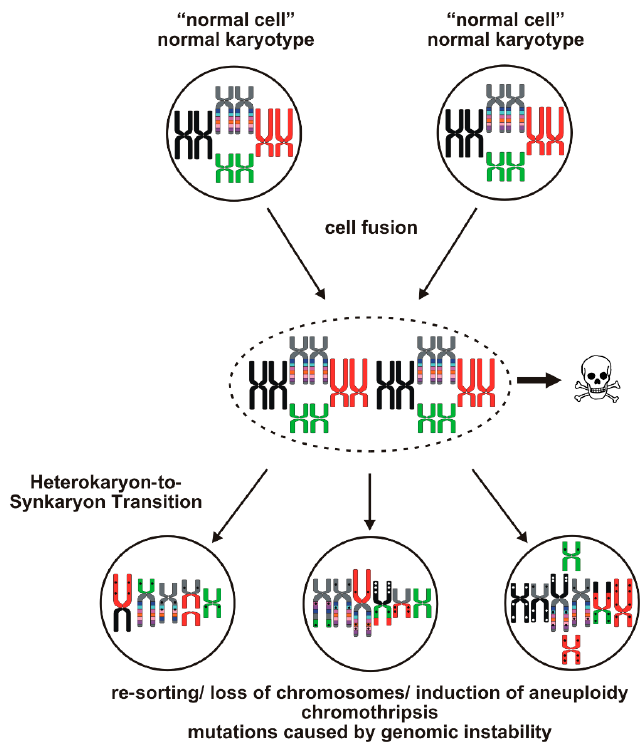
Figure 1. Induction of genomic instability by cell fusion. Fusion of two cells first result in heterokaryon being a hybrid cell with at least two distinct nuclei. The heterokaryon-to-synkaryon transition, representing the fusion of two parental nuclei to one hybrid nucleus, is a potent inducer of genomic instability in cells and is associated with a re-sorting, loss of chromosomes and putatively chromothripsis resulting in unique hybrid cells exhibiting an aneuploid karyotype and multiple mutations (indicated by small dots). However, most of the heterokaryons will die due to activation of tumor suppressor genes.